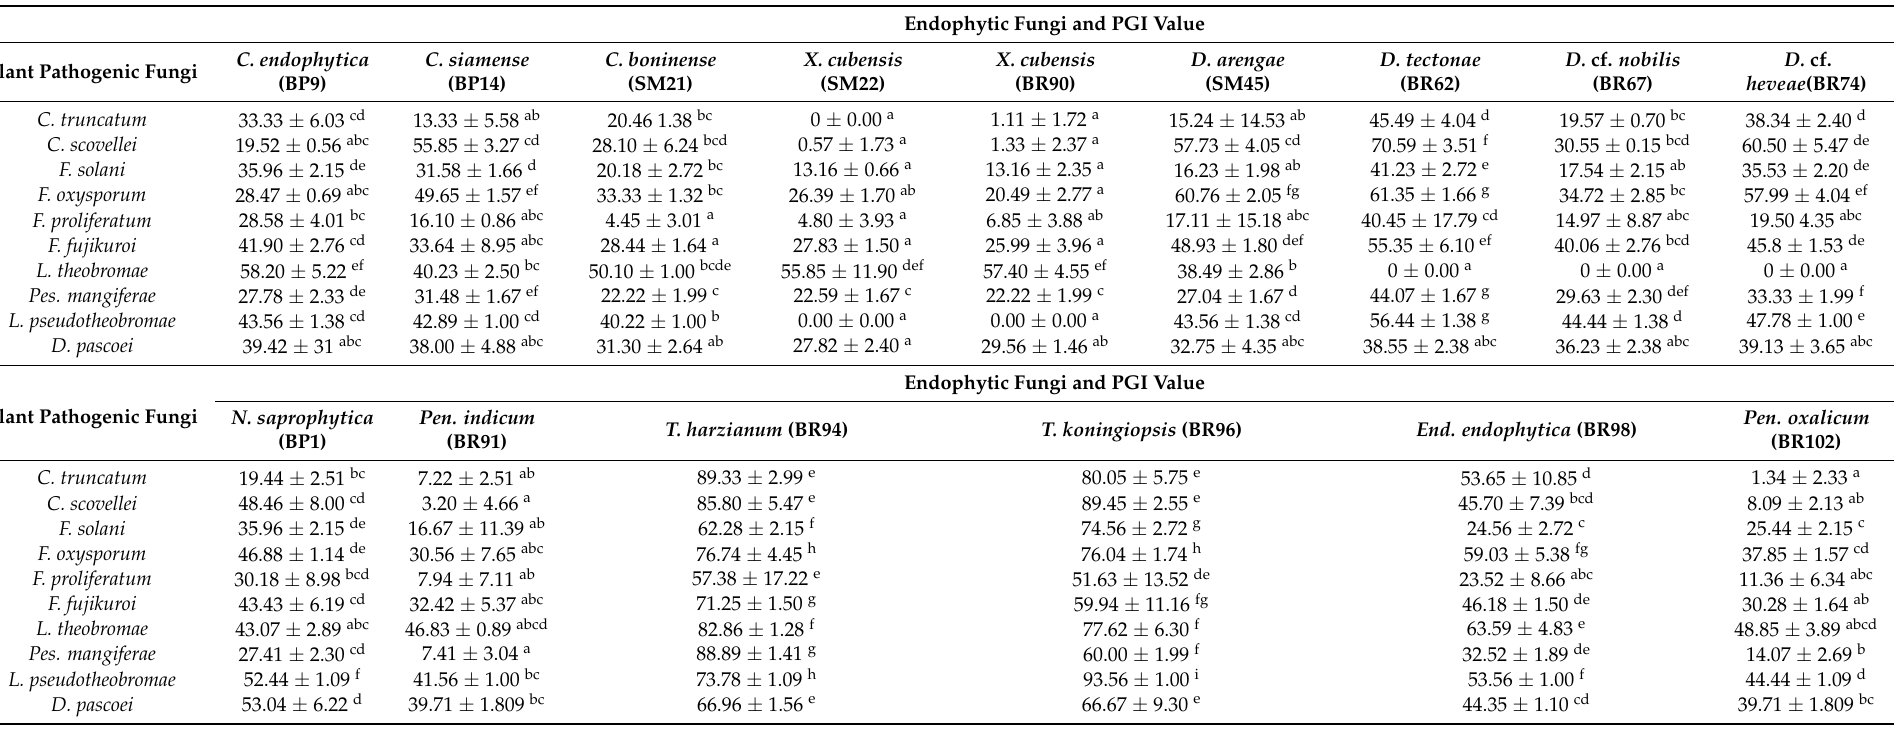
Table 4. Antagonistic activity of endophytic fungi against plant pathogenic fungi in dual culture